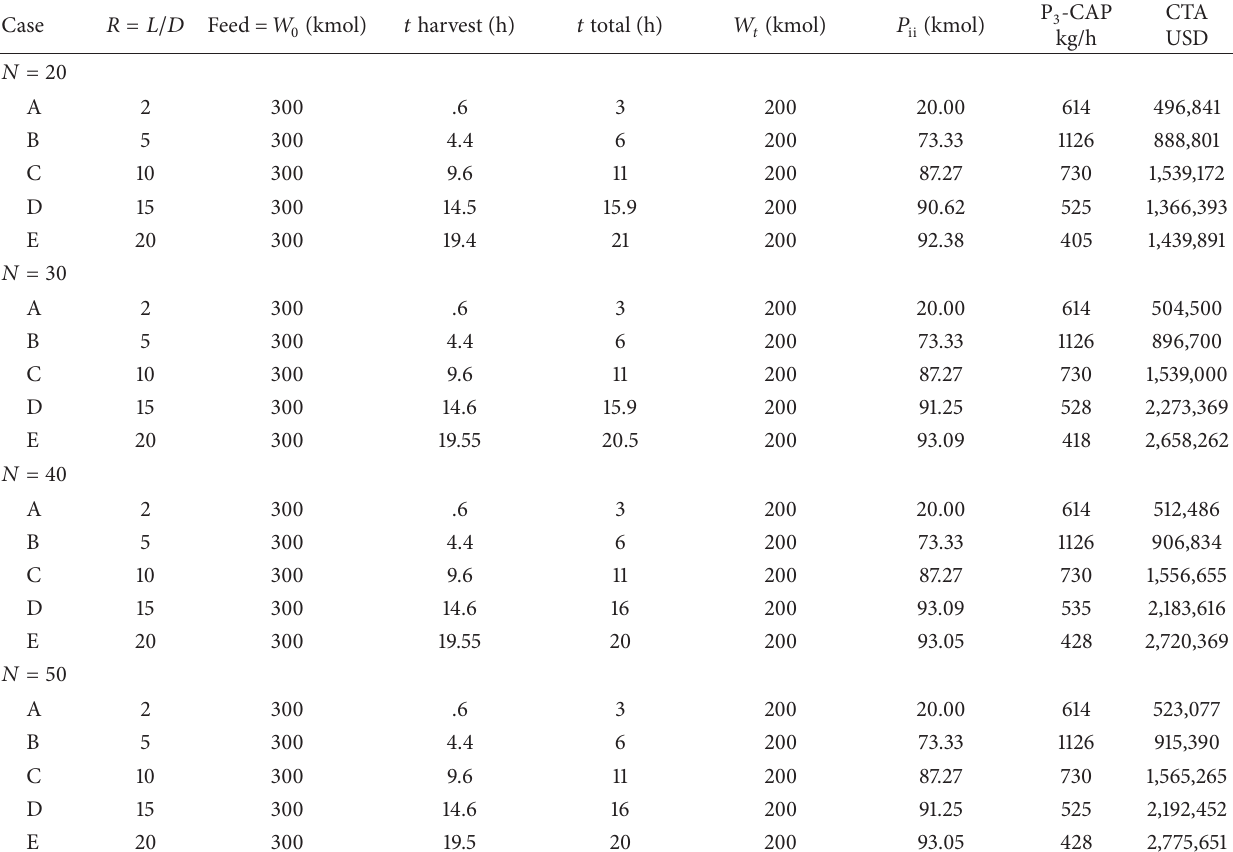
Table 5: Three components separation: toluene (ii), ethylbenzene (iii), and xylene (iv) at constant